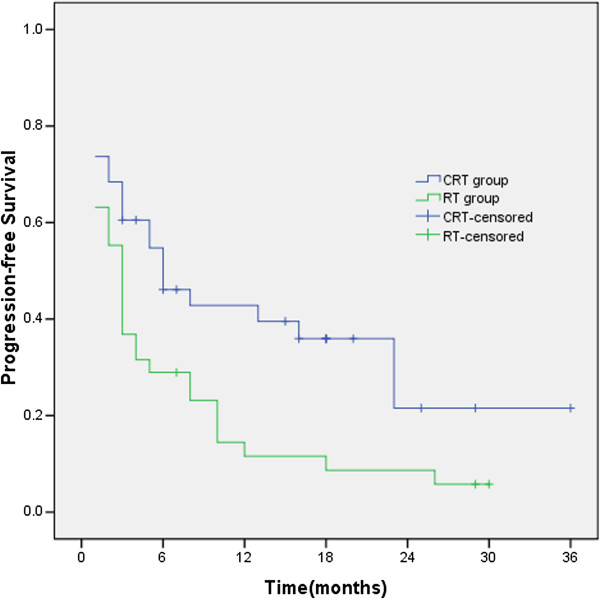
The median PFS time and 1-and 2-year PFS rates in CRT group and RT group were 6 months, 42.8%, 21.6% and 3 months, 11.6%, 8.7% (χ2 = 6.02, p = 0.014), respectively.